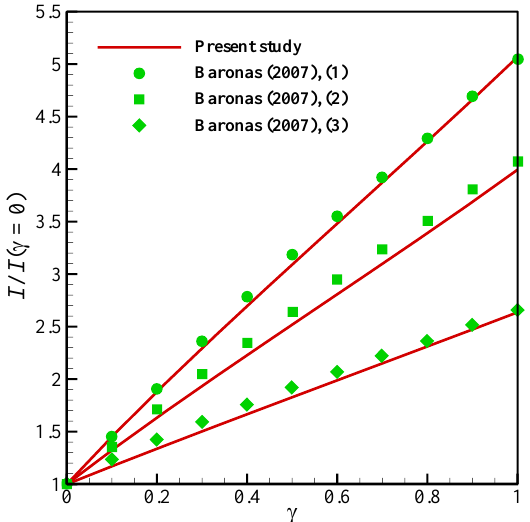
Figure 5. Comparison between the results of the present study and Baronas [20] in cylindrical geometry for different values of the enzyme filling level ( γ ) and the perforation level ( α ): V max = 100 µ M. (1) a 1 = 1 µ m, S 0 = 1 µ M; (2) a 1 = 0.8 µ m, S 0 = 100 µ M; (3) a 1 = 0.4 µ m, S 0 = 100 µ M.